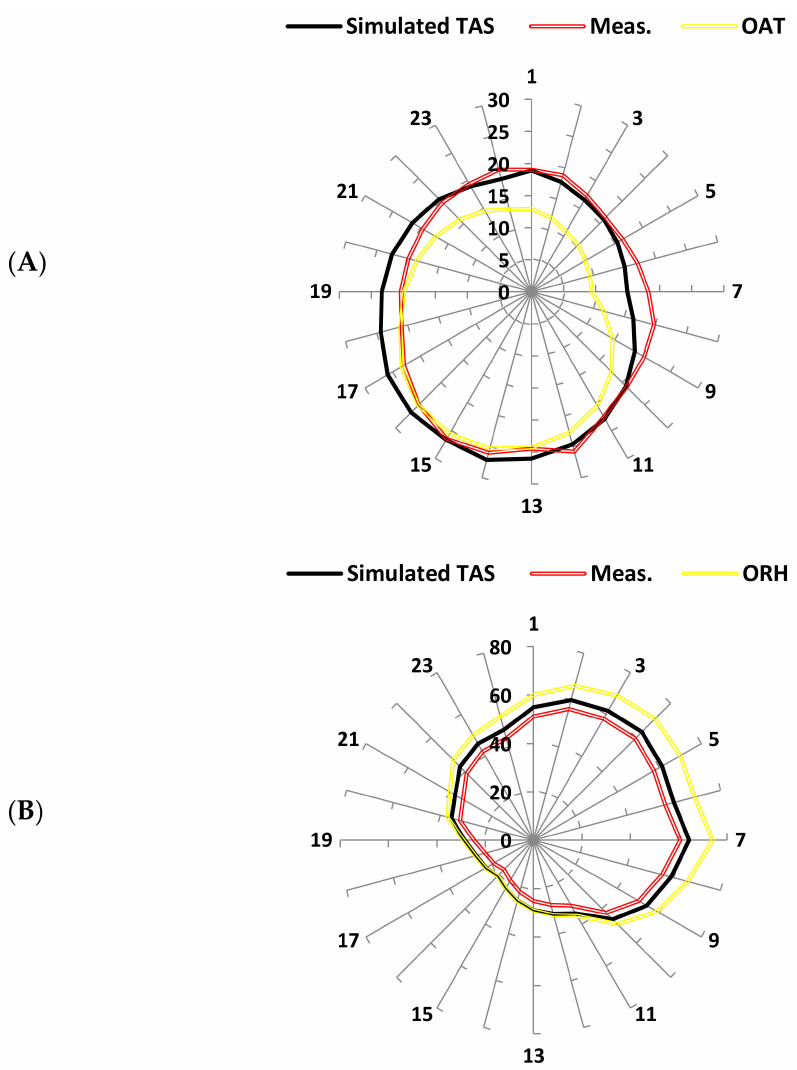
Figure 7. Calibration: ( A ) indoor temperatures ( ◦ C) and ( B ) relative humidity